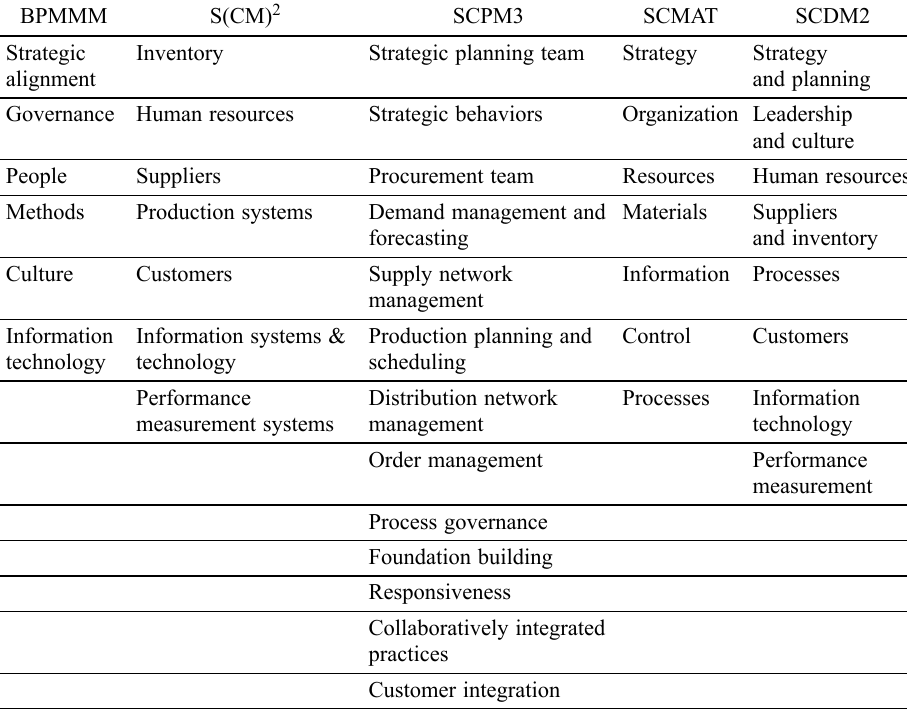
Table 1. Benchmarking of supply chain management maturity